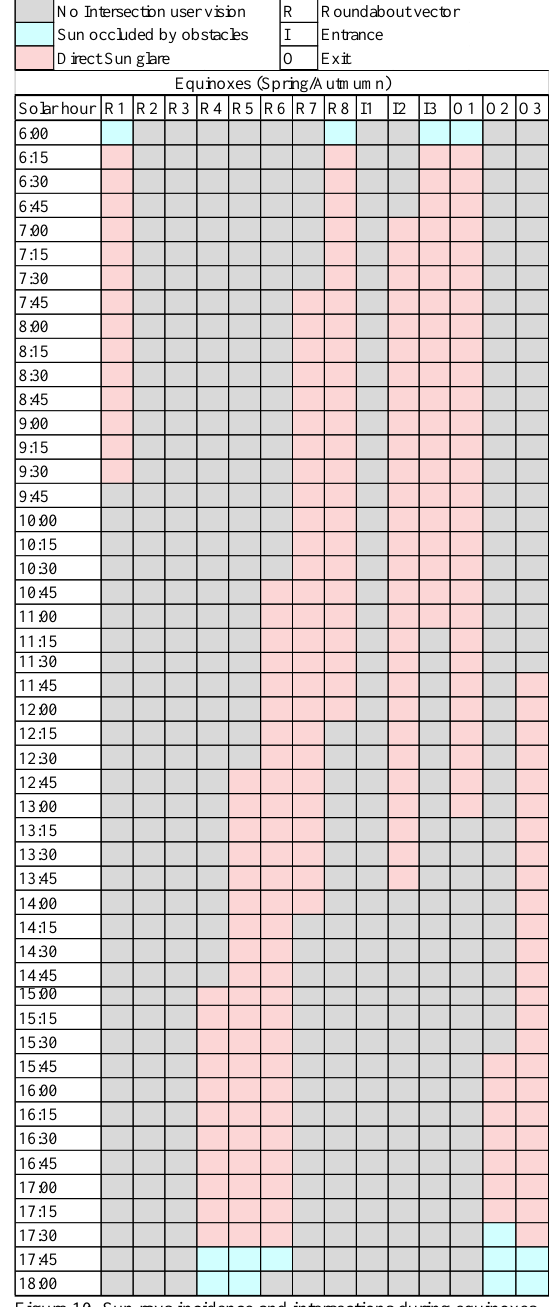
Figure 10. Sun rays incidence and intersections during